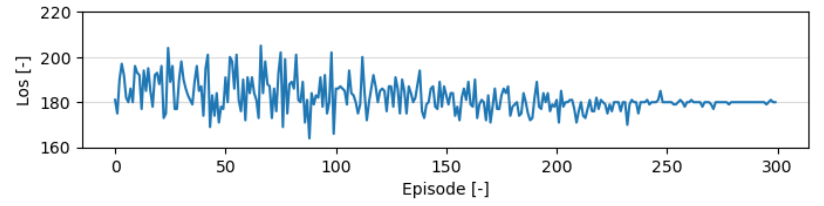
Figure 13. Total number of losses of separation per episode during the training of the RL agent.